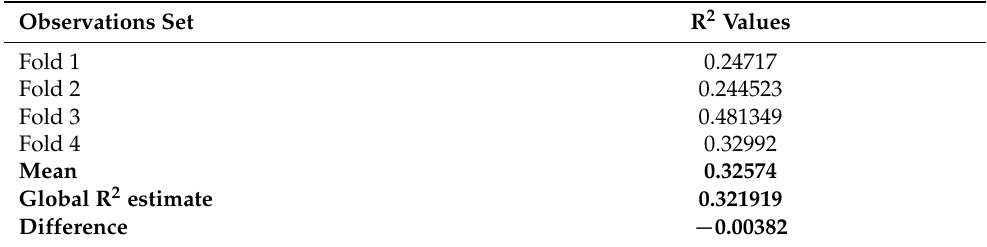
Table 3. Four-fold cross validation of 7-days lag